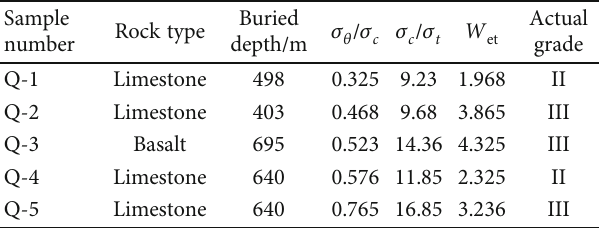
Table 3: Rockburst data and prediction results of Laobishan